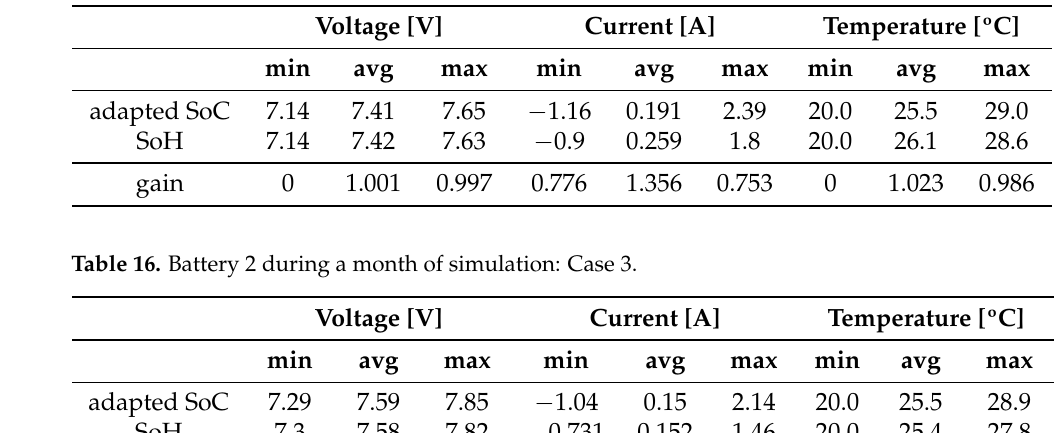
Table 15. Battery 1 during a month of simulation: Case 3.